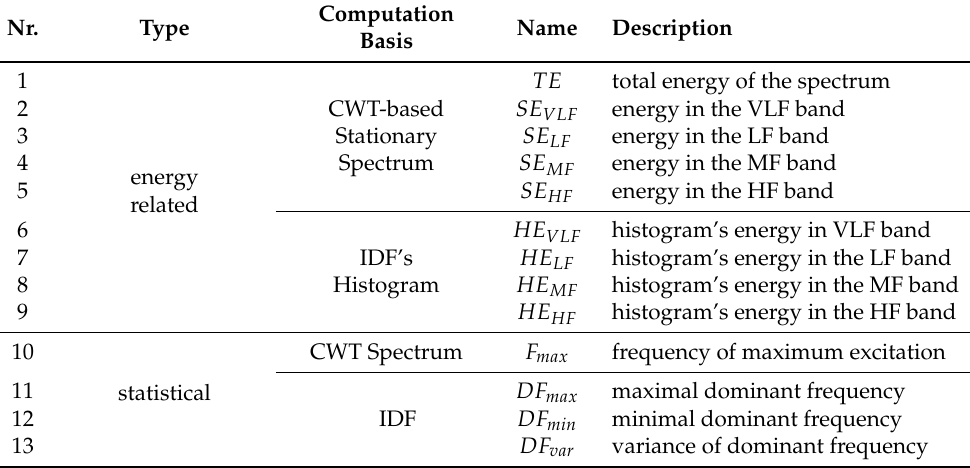
Table 2. Summary of the energy-related and statistical features derived from the computed indicators. Nr.